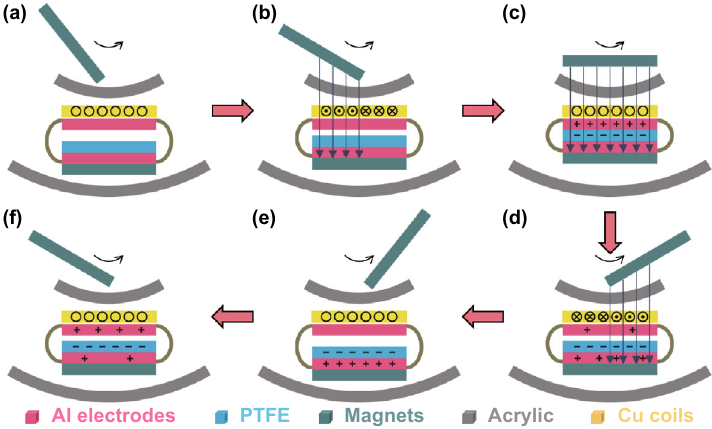
Fig. 2 Schematics of the operating principle of the TEHG. a Initial state. b Current generation process of the RF-EMG. c The rotary magnet is aligned to copper coil. d The rotary magnet gradually moves away. e The CS-TENG completely recovers its shape. f Another magnet approaches the CS-TENG